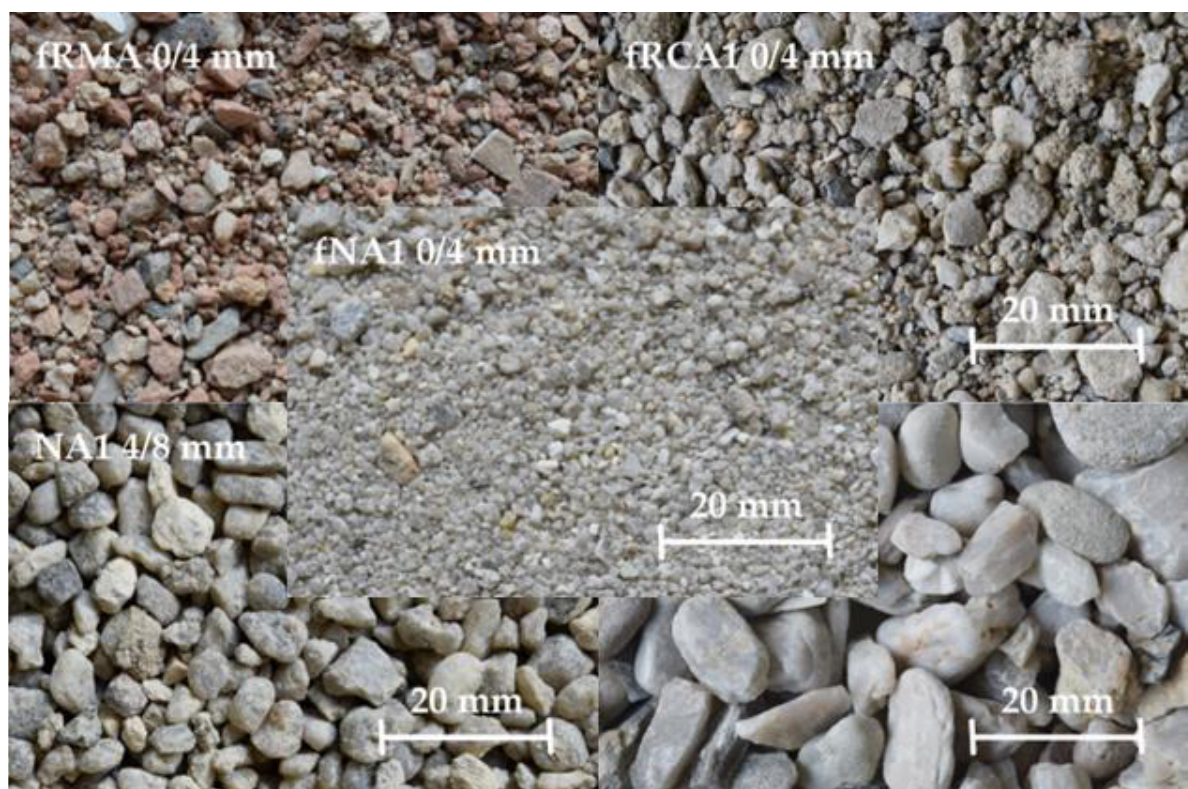
Figure 1. NA and RA used in concrete mixtures.